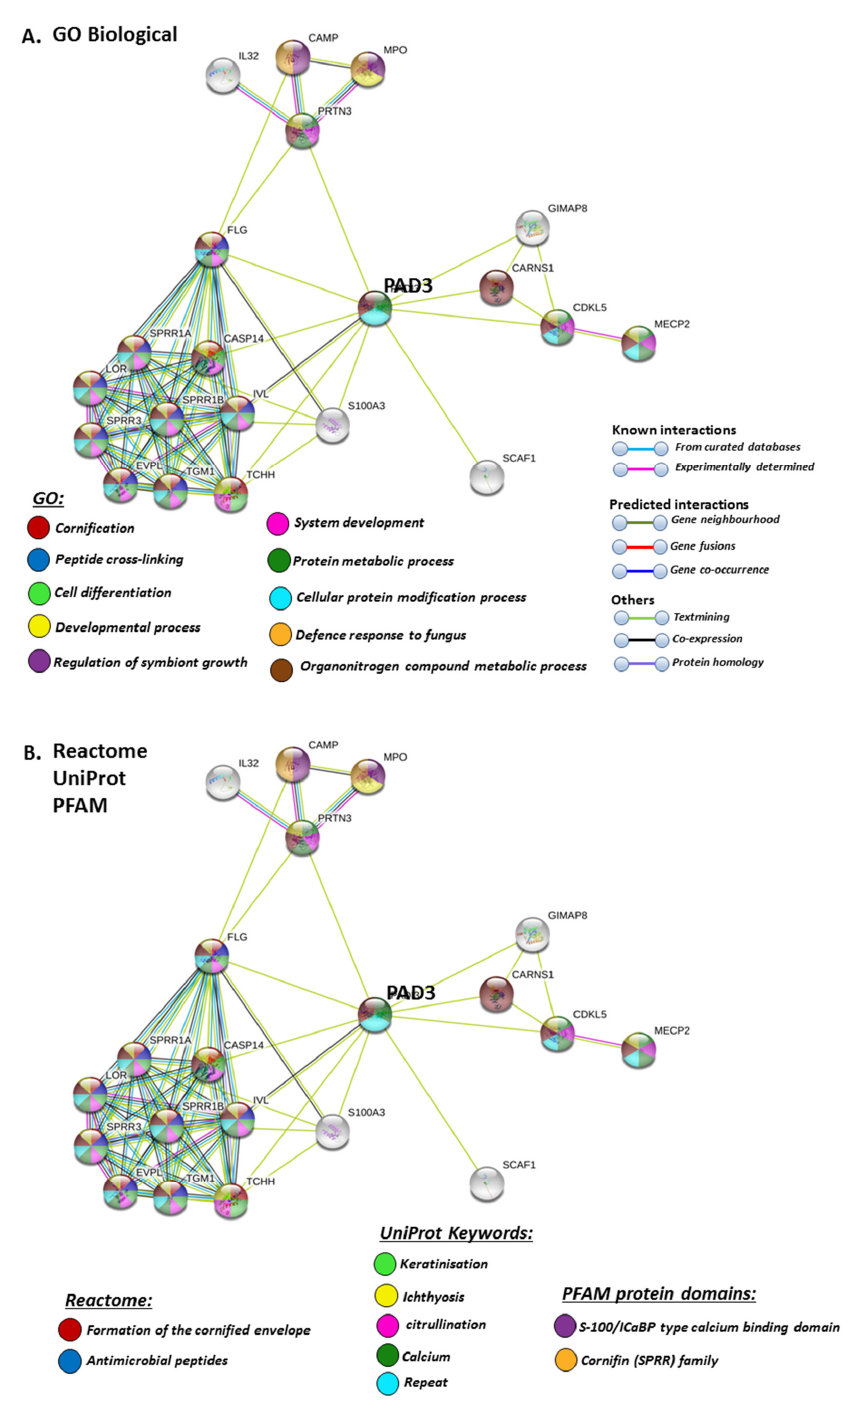
Figure 7. GO and Reactome pathway analysis for PAD3, highlighting GO biological pathways ( A ) Reactome pathways, UniProt keywords and PFAM protein domains ( B ) Colour code for the di ff erent pathways is shown within the figure. Individual coloured lines represent specific protein interactions that have been identified through interactions that are known (referring to experimentally determined connections and curated databases), through interactions that are predicted (referring to gene fusion, gene neighbourhood, gene co-occurrence) or through interactions identified via text mining, co-expression or protein homology (please refer to the colour key provided in the figure for the di ff erent connective lines) (PPI enrichment p -value: 2.22 × 10 − 16